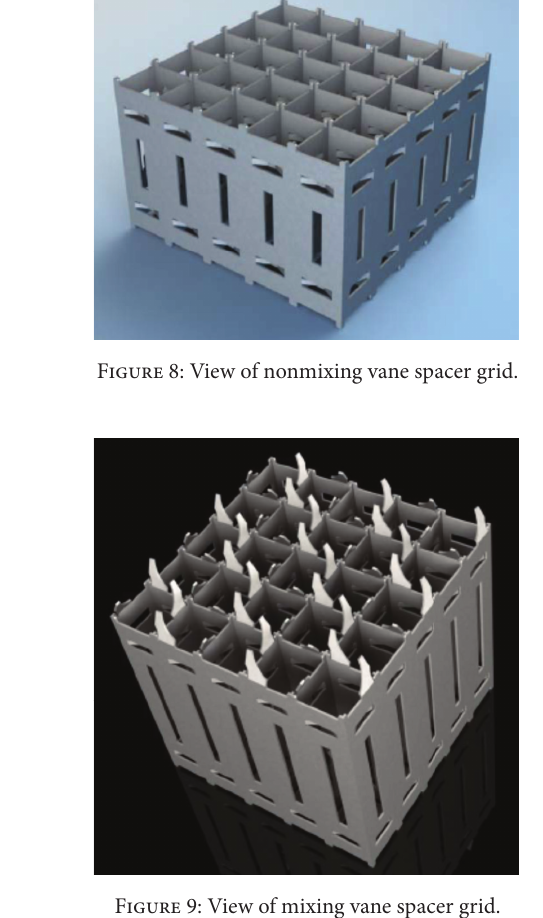
Figure 9: View of mixing vane spacer